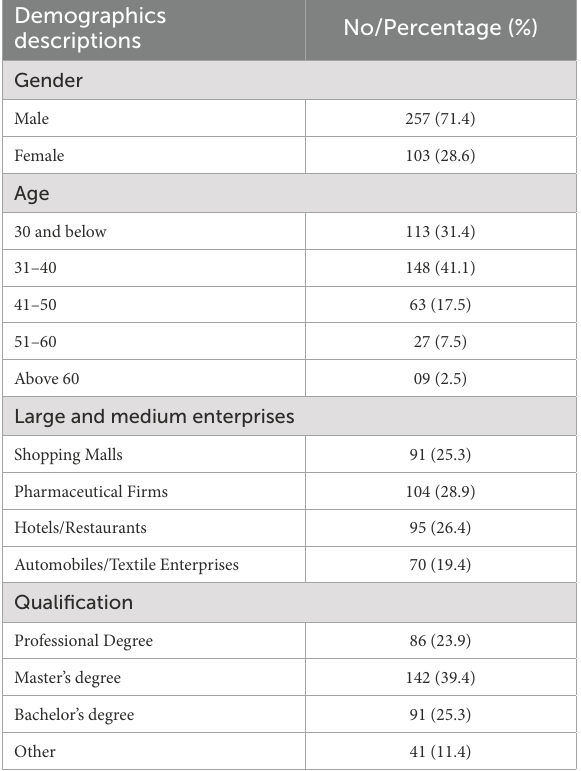
TABLE 1 Demographic statistics of study participants ( n =